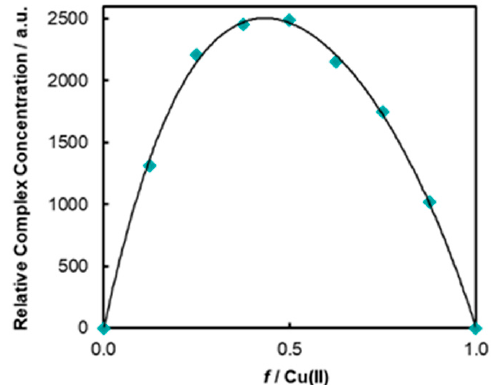
Figure 3. Job plot for complex formation between host 5 and Cu(II) in CH 3 CN (at constant 1.0 × 10 − 5 M total concentration) as obtained from changes in fluorescence ( λ exc = 380 nm).